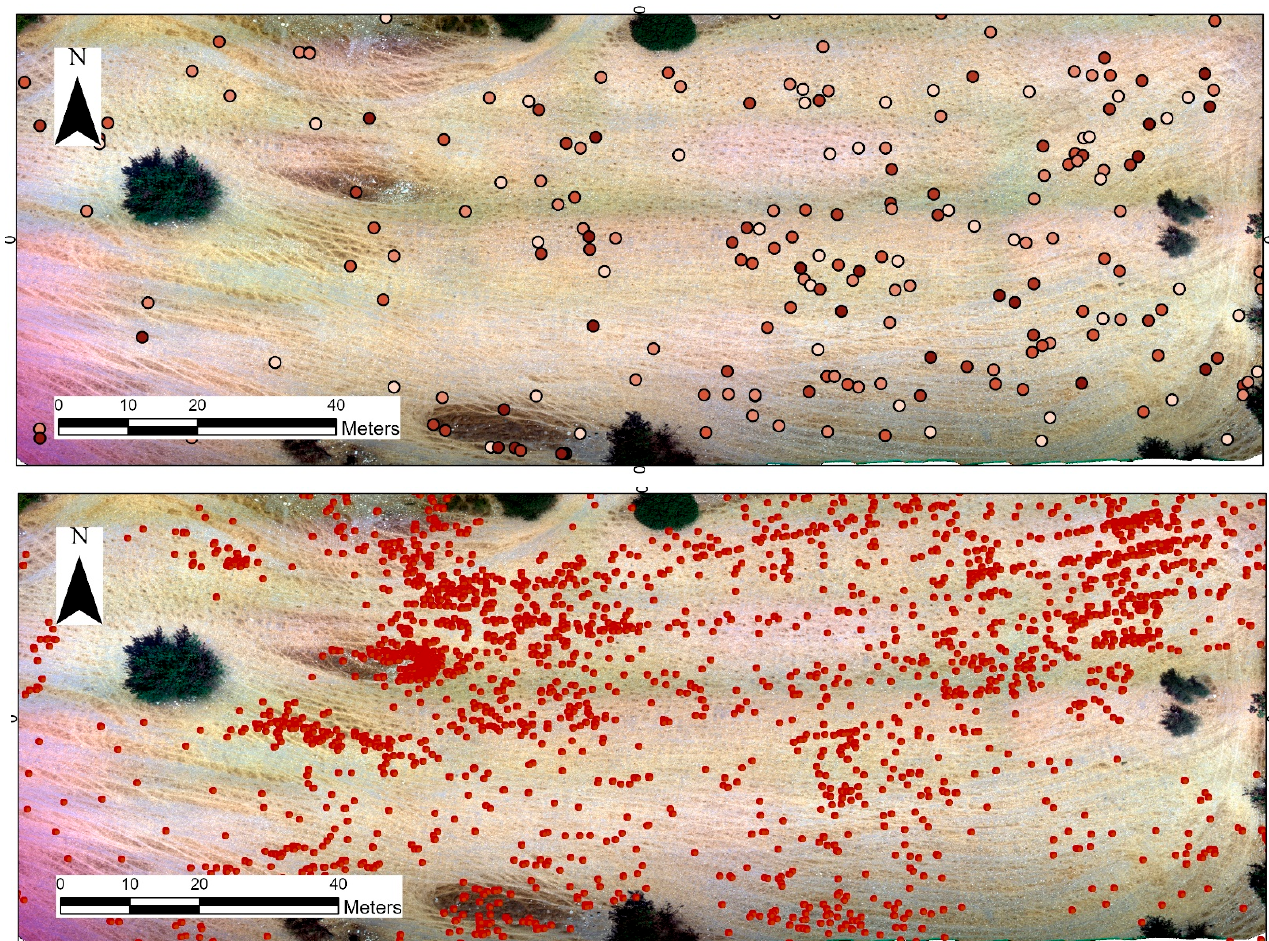
Figure A1. Potsherd detection (points) using the Single Shot deep learning algorithm over Area 6 (southern part) ( top ) and the relevant results from the random forest classification ( bottom ).